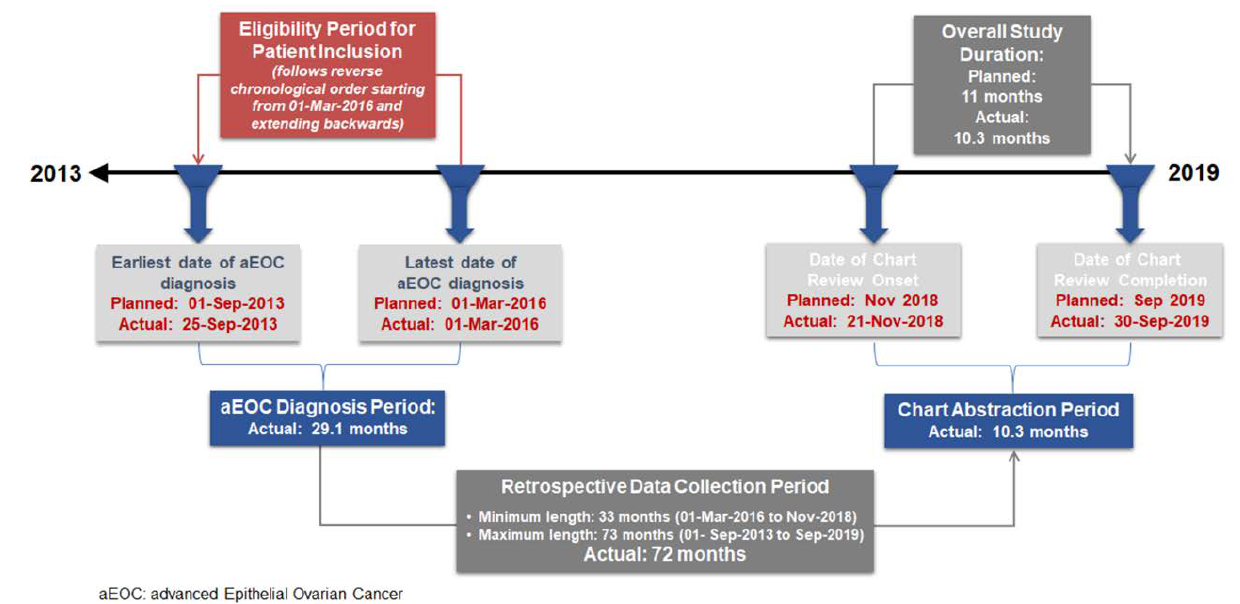
Figure 1. Retrospective chart review flow chart.